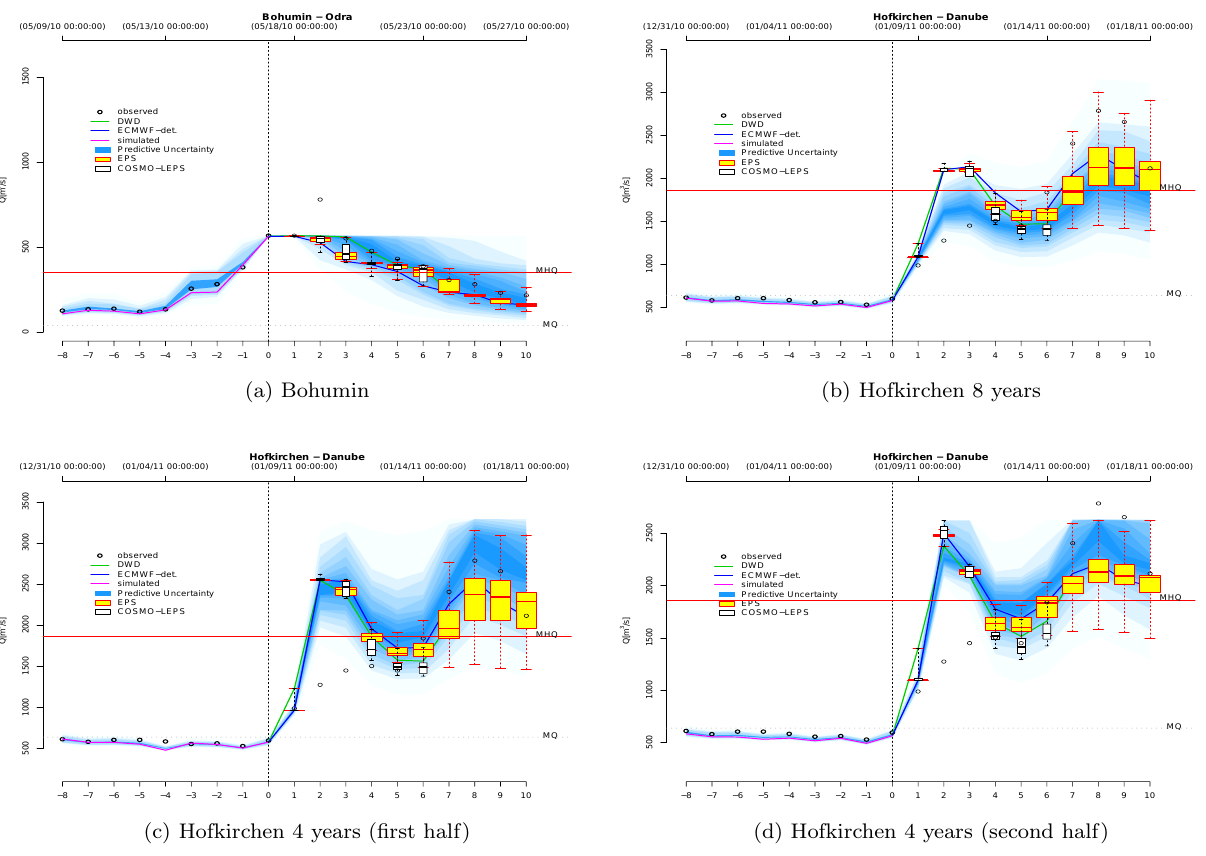
Fig. 2. Corrected forecast of a flood event without extrapolation in May 2010 at station Bohumin (a) , and in January 2011 at Hofkirchen taking eight years of observation (b) , eliminating the first half of the data set (c) , eliminating the second half of the data set (d) . At station Bohumin (a) and in the second reduced sample at station Hofkirchen (d) the upper limit of applicability is shown, when the maximum of the historical sample is exceeded during the forecast